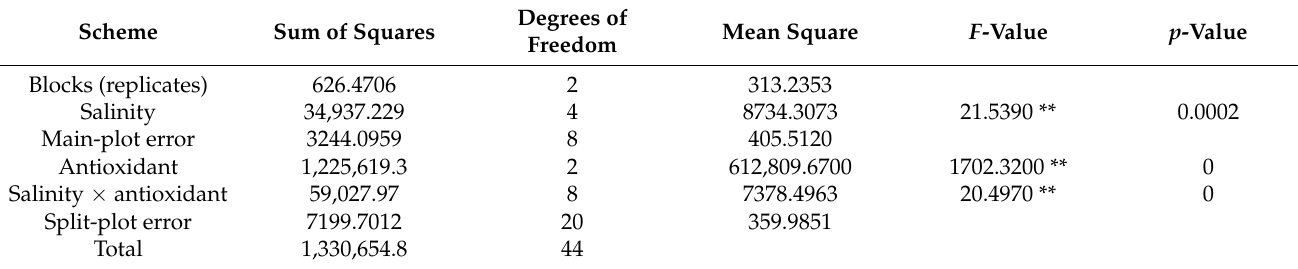
Table 1. Split-plot analysis of variance for S. maximus salinity resistance experiment, with five salinity gradients and three antioxidant